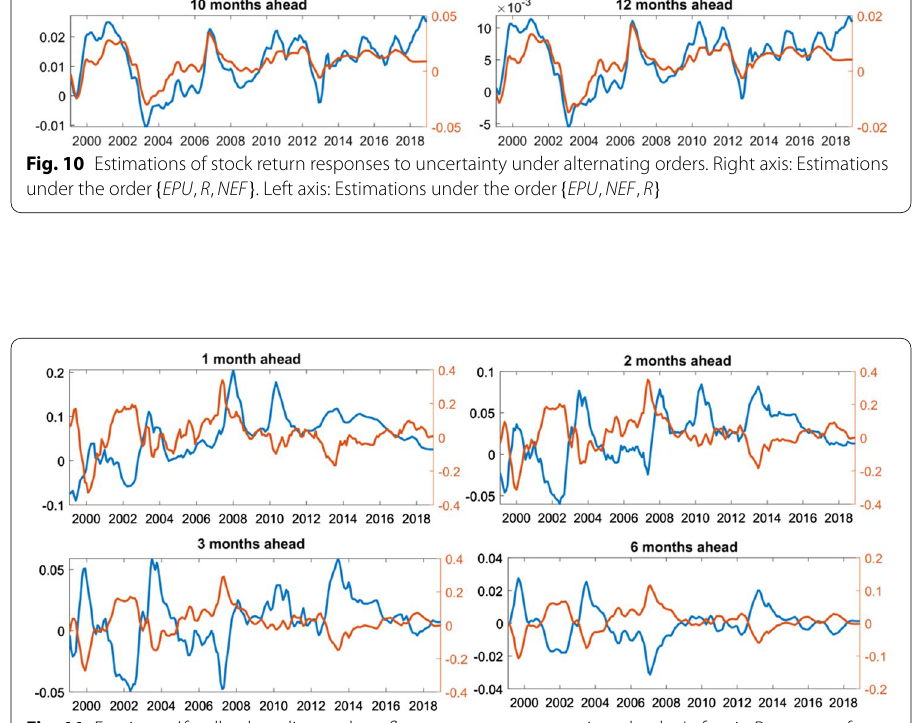
Fig. 11 Foreigners’ feedback trading and net flow response to uncertainty shocks. Left axis: Response of net flows to stock return shocks (blue). Right axis: Response of net flows to uncertainty shocks